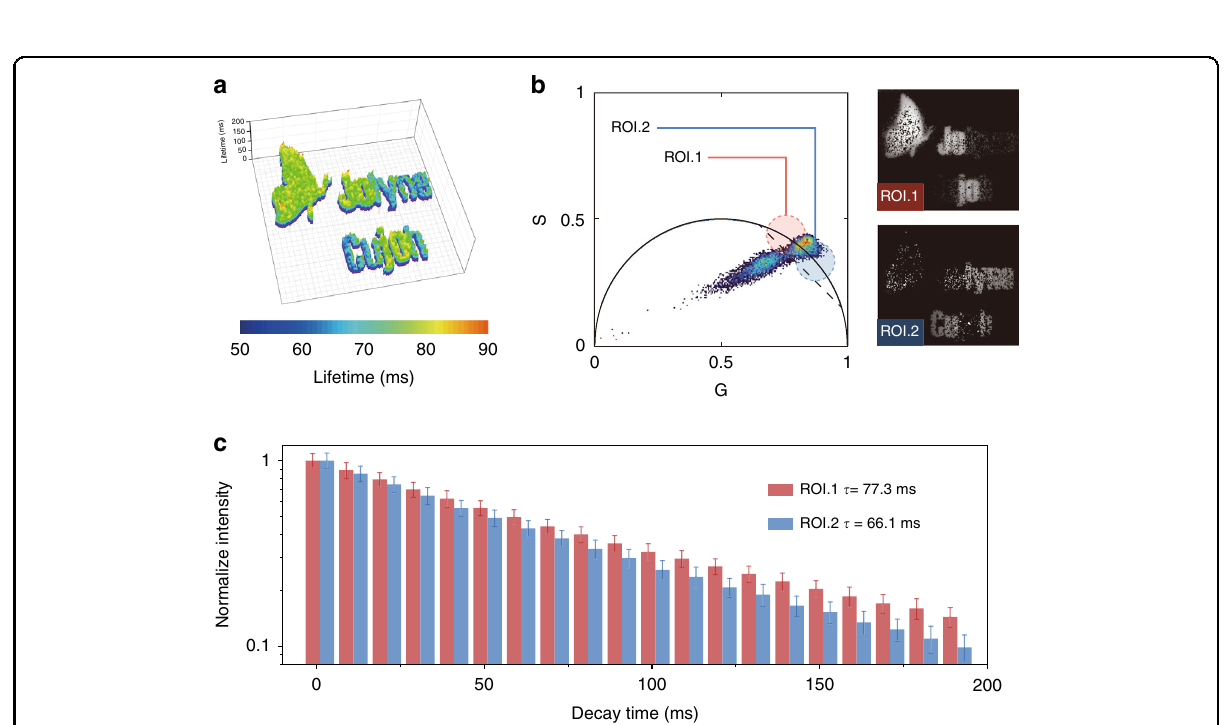
Fig. 6 Multilayered message decrypted by lifetime imaging. a Lifetime mapping of the steganographic pattern. b Phasor analysis of the steganographic pattern. c Average decay pro fi les of the pixels in two different ROIs